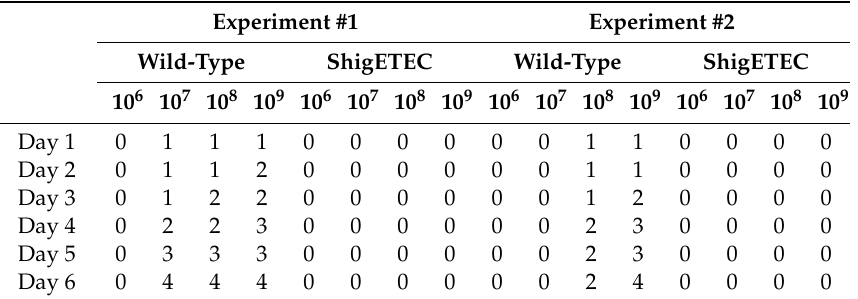
Table 2. Severity scores of eyes infected with either ShigETEC or the parental wild-type Shigella flexneri 2a 2457T strain in the Guinea pig keratoconjunctivitis model (Ser é ny